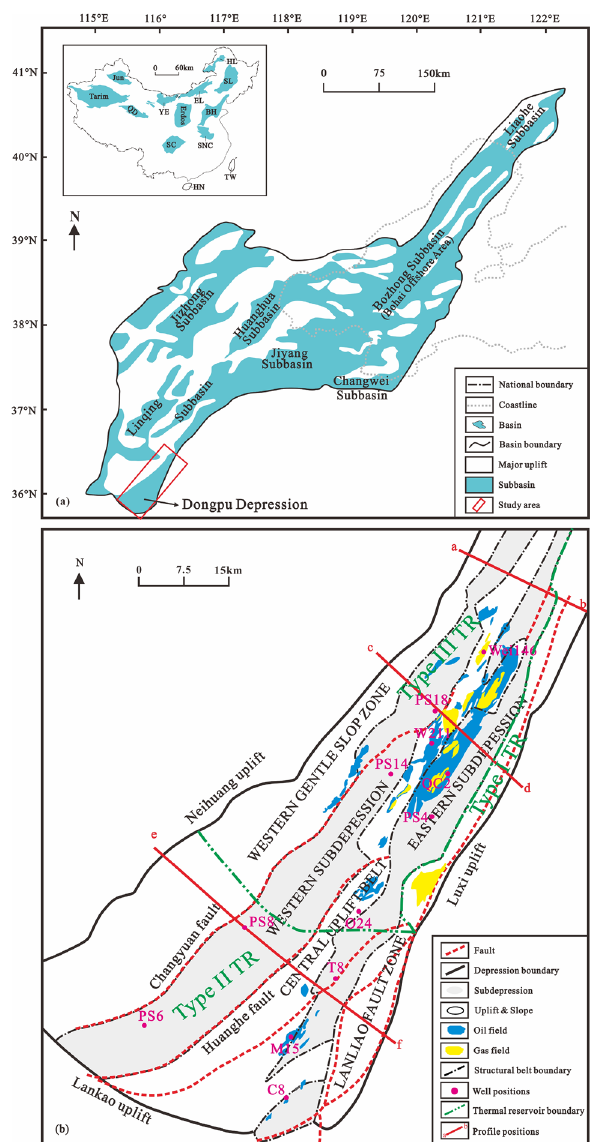
Depression. TW = Taiwan; HN = Hainan; SC = Sichuan; BH = Bohai Bay; Jun = Junggar; QD = Qaidam; YE = Yingen-Ejinaqi; EL = Erlian; HL = Hailaer; SL = Songliao; SNC = Southern part of North China; GTR = Geothermal reservoirs; Type I GTR is a well-developed karst carbonate rock; Type II GTR is a medium developed karst carbonate rock; Type III GTR is an underdeveloped karst carbonate rock. Figures were produced by CorelDRAW Graphics Suite X8 (https:// www. corel. com/